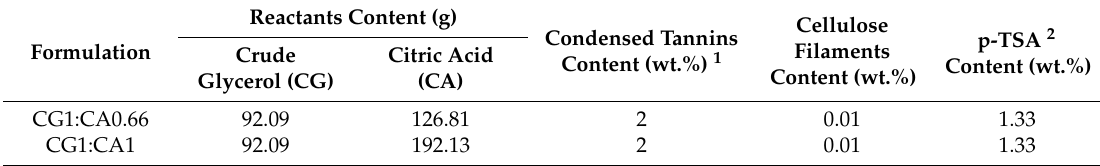
Table 1. Composition of the bio-based adhesive formulations.